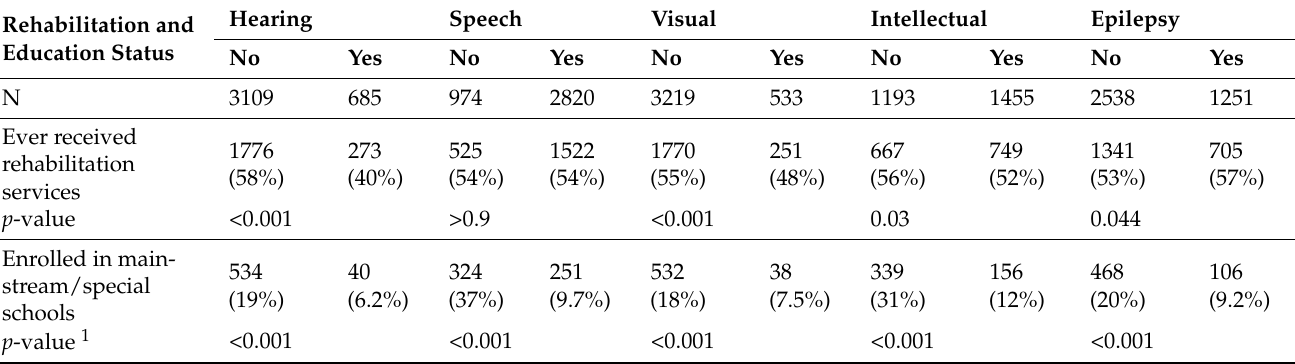
Table 4. Rehabilitation and education status of children with different forms of associated